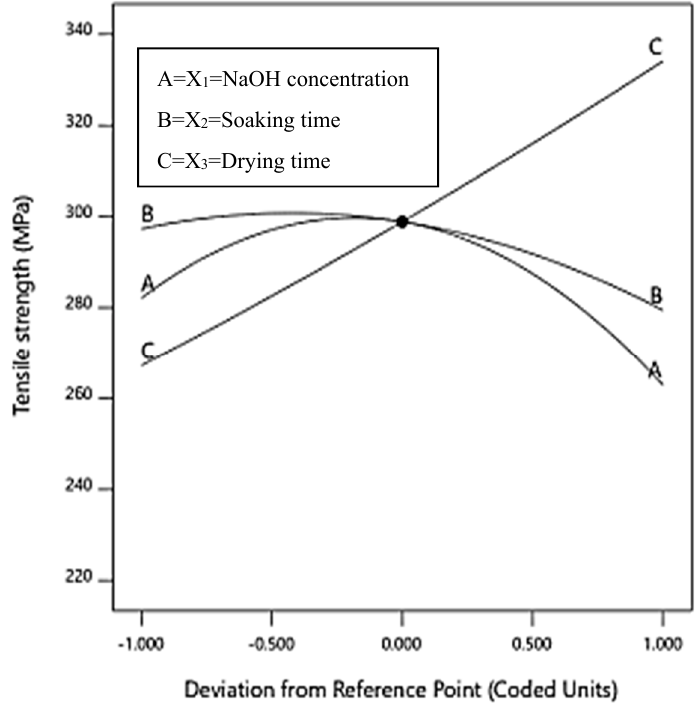
ff ect of all the variables on the tensile Figure 6. Perturbation plot showing the effect of all the variables on the tensile strength. Figure 6. Perturbation plot showing the e